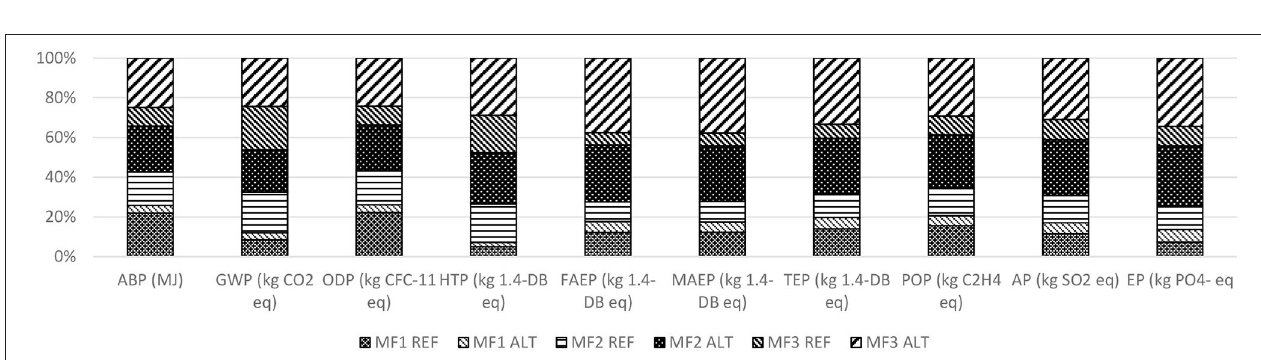
FIGURE 6 | Contribution analysis of the 3 workshops reference scenarios and their alternatives. MOREFISH workshop 1 is designated as MF1, MOREFISH workshop 2 as MF2